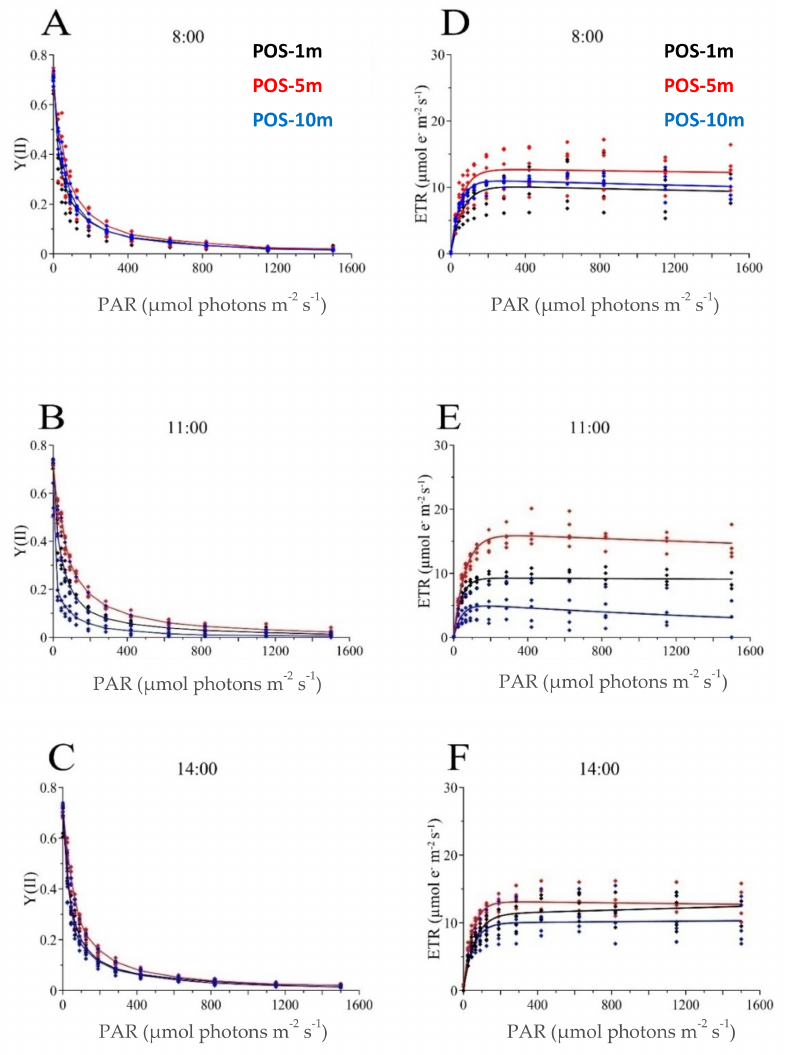
Figure 5. RLCs curves of P.oceanica sampled during POSI-Aug at POS-1m (black),POS-5m (red) stations. ( A–C ) Y(II) and ( D–F ) ETR as a function of PAR. Squared dots represent all the measures, while the continuous curve is given by the median values and the fit calculated according to